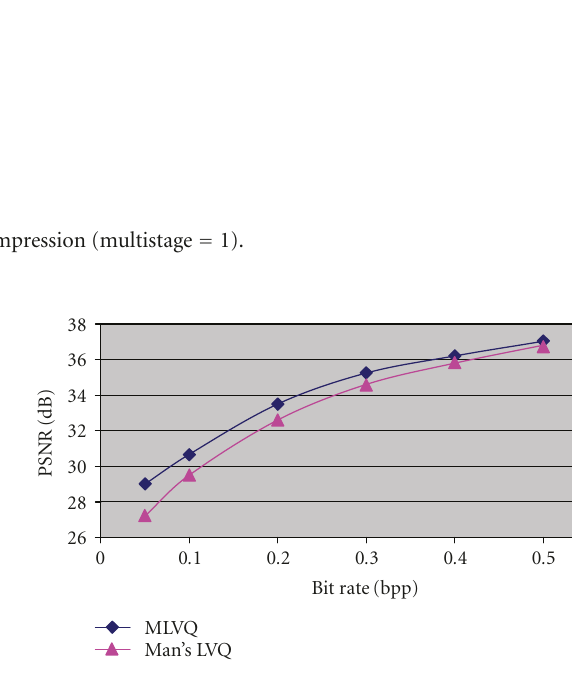
Figure 7: Comparison with Man’s LVQ [2] for image Lena 512 × 512.